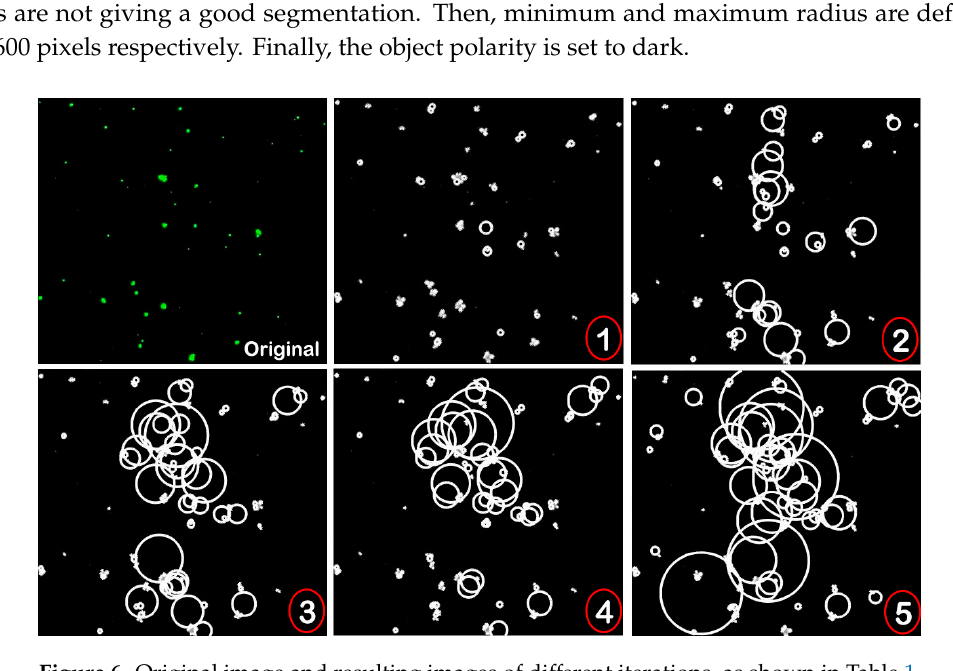
Figure 6. Original image and resulting images of different iterations, as shown in Table 1.